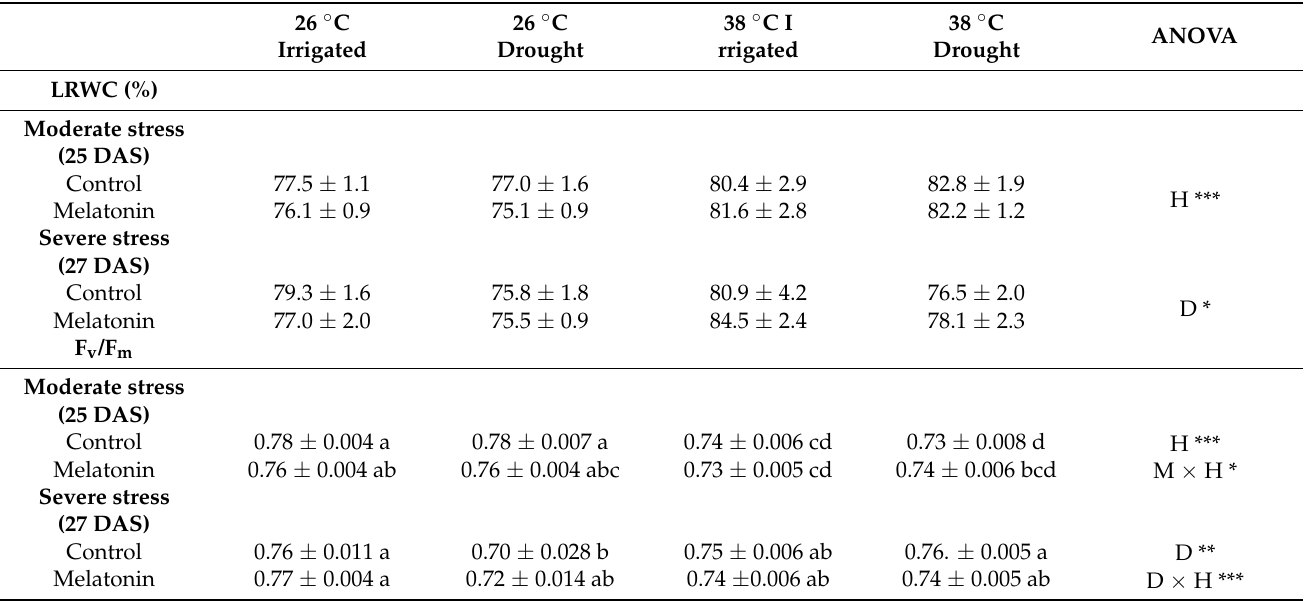
Table 2. Leaf relative water content (LRWC) and PSII photochemistry (F v /F m ) in dark-adapted leaves obtained during moderate stress (drought-stressed at SRWC ~50% and heat stress for 1 day) and severe stress (drought-stressed at SRWC ~20% and heat stress for 3 days). Values are mean ± SE. The effects of the three factors studied—heat stress (H), drought stress (D), melatonin treatment (M)—and their interaction are indicated in the column to the right. Significance levels are indicated by ***, p < 0.001; **, p < 0.01; *, p < 0.05, whereas factors with no significant effect ( p > 0.05) are not listed. Letters next to the values indicates differences between groups significant at p < 0.05 in the post hoc multiple